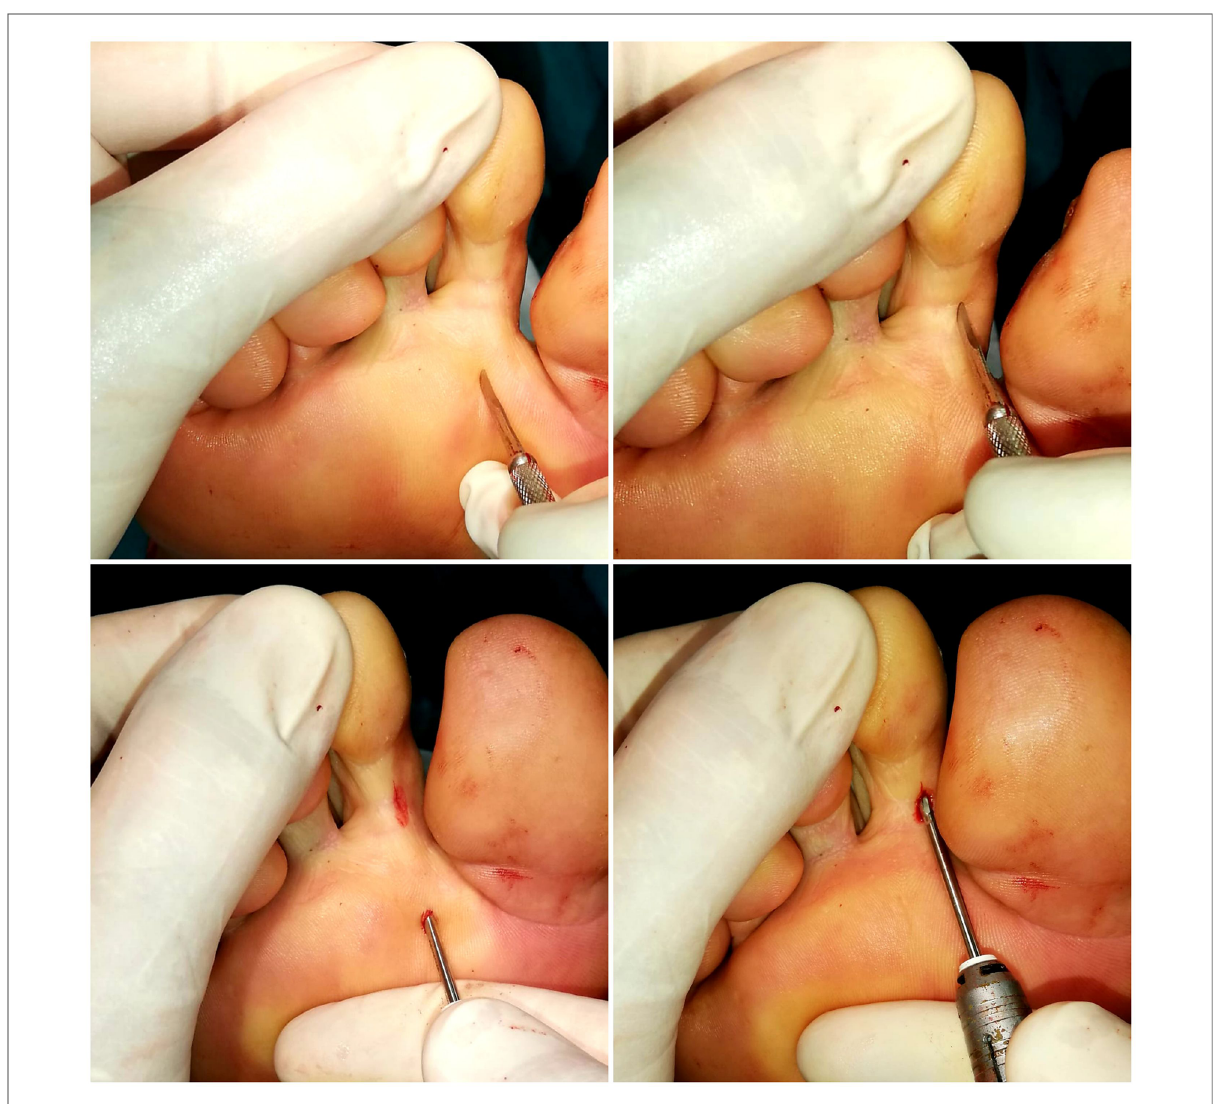
FIGURE 1 Surgical procedure for the correction of claw toe with osteotomy at the base of the phalanx and claw